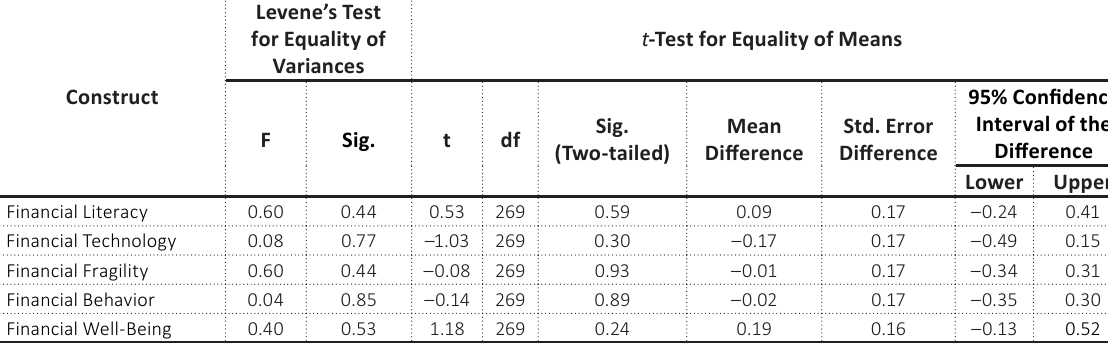
Table 16. One-way ANOVA across students who kept expense records never/rarely/sometimes/regularly Construct